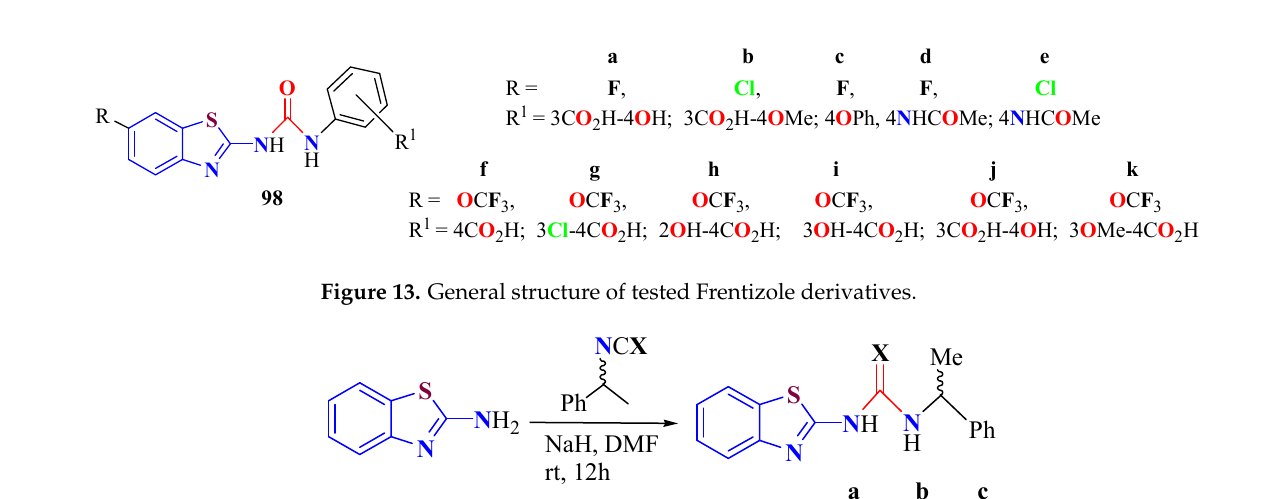
Scheme 40. Chiral UBT 99a and TUBTs 99b , c from chiral isocyanate or thiocyanate.